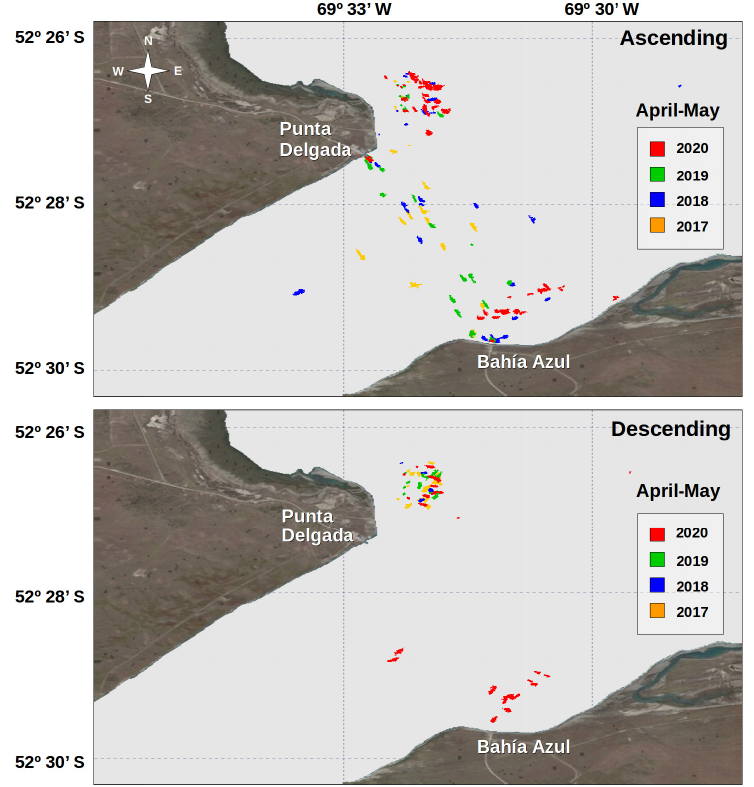
Figure 6. Maps based on the SAR images analyzed in the Strait of Magellan during April and May for the study period (2017–2020). Different colors represent the results by year for ascending passes ( upper panel ) and descending passes ( bottom panel map